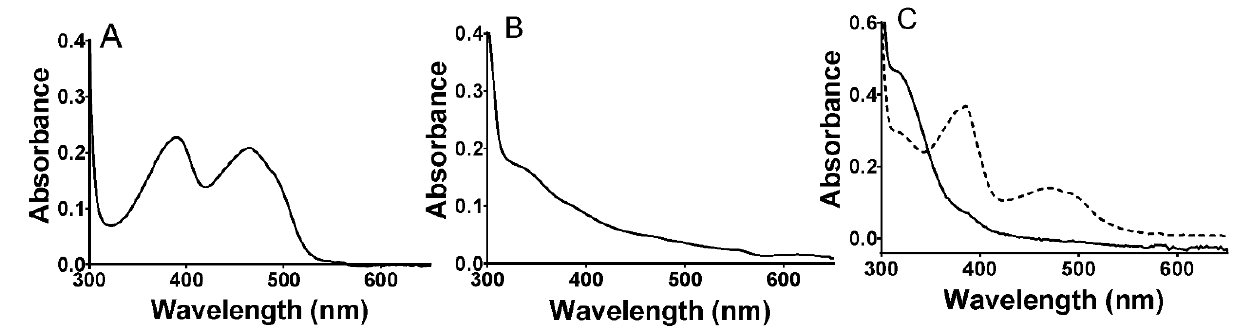
Figure 1. Absorbance spectra of P. luteoviolacea CPMOR-1 LAAO. ( A ). Spectrum of the as-isolated protein in the oxidized state. ( B ). Spectrum immediately after the addition of 1 mM methionine. ( C ). Spectra after the addition of a 20-fold excess of sodium dithionite. The dashed line spectrum was recorded immediately after the addition and the solid line spectrum was recorded approximately 8 min after mixing. Spectra were recorded of 30 μ M LAAO in 50 mM potassium phosphate, pH 7.0. Comparison of the amino acid sequences of the LAAOs from P. luteoviolacea CPMOR-1 and CPMOR-2 indicated that they exhibit an 86.8% identity and 93.7% similarity. The